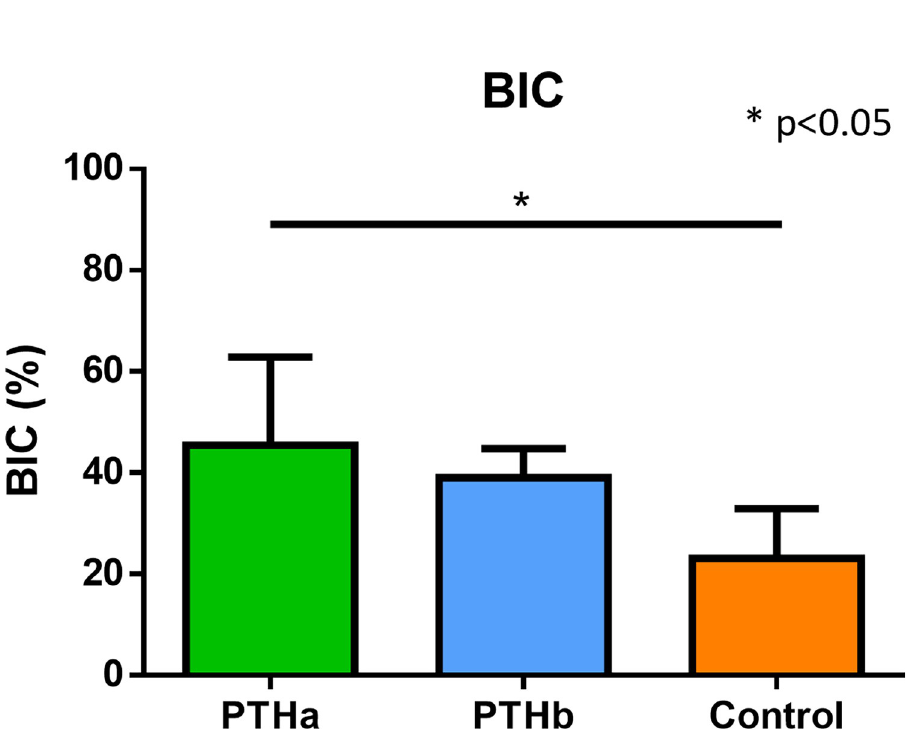
Fig 5. BIC. The BIC values of the PTHa group were significantly higher than those of the PTHb and Control groups. There was no significant difference between the PTHb and Control groups.